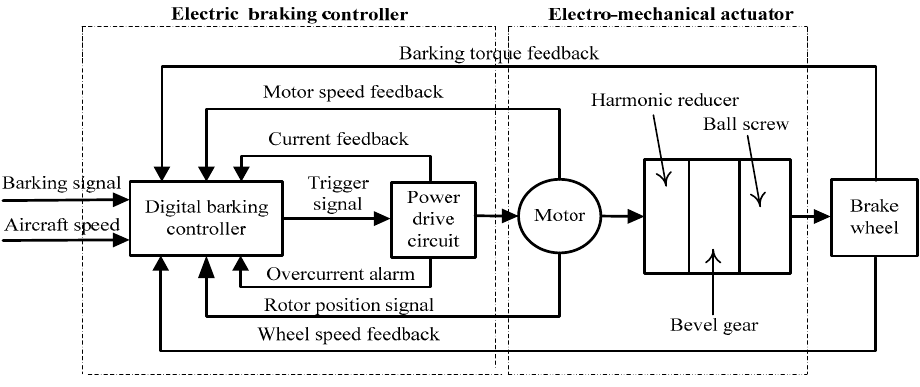
Figure 1. Structure of the all-electric braking system.